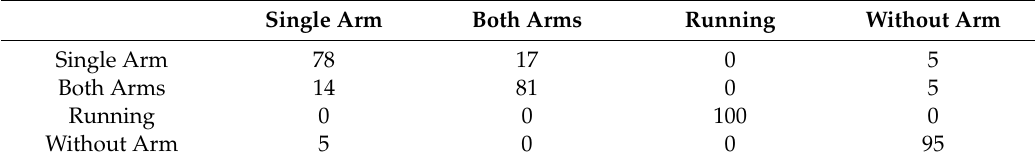
Table 2. Confusion matrix results of Short-Time Fourier Transform (STFT).